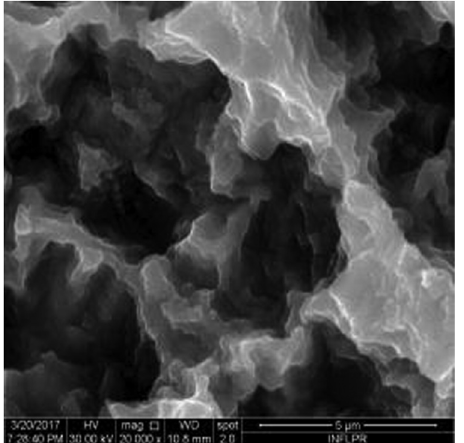
Figure 4: SEM image of sample S4 at a magni fi cation of 20k × .